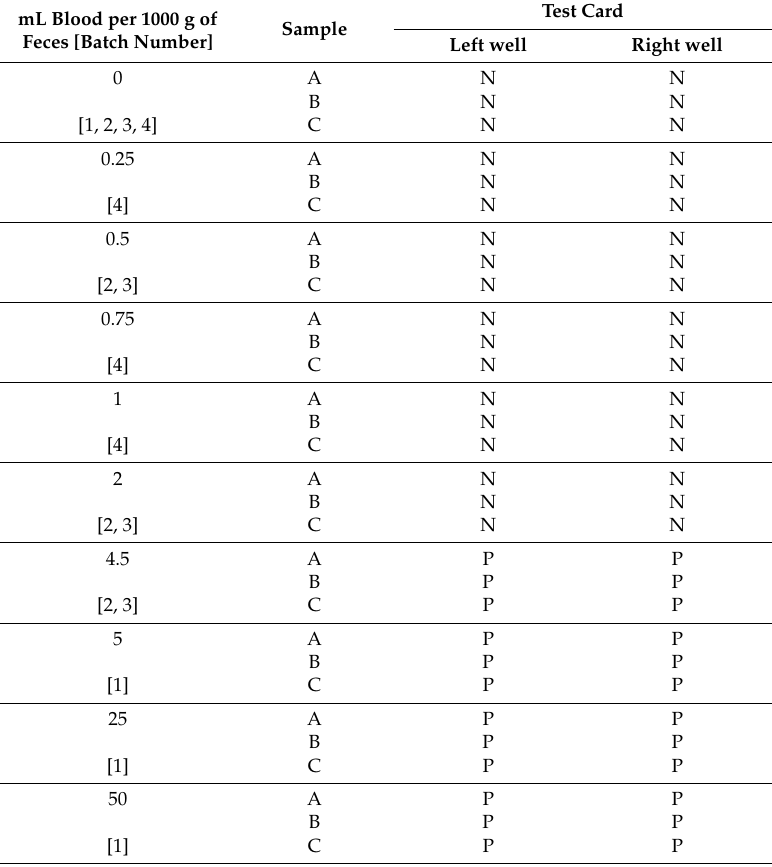
Table 3. In vitro test of the analytical detection limit of the Hemoccult II ® SENSA ® test using bovine feces and blood. The letters A, B and C are the repeated samples made on each mix of feces and whole blood (sub-batches). The letters “N” and “P” represents the negative and positive test results, respectively. Batches 1 and 2 were comprised of feces from two cows whereas Batches 3 and 4 were made with feces from one cow. Batches 2 and 3 were equal in both blood volumes and results, hence they were shown as one result. Likewise, the four sub-batches with 0 mL of blood added to the feces are shown as one result. mL Blood per 1000 g of Feces [Batch